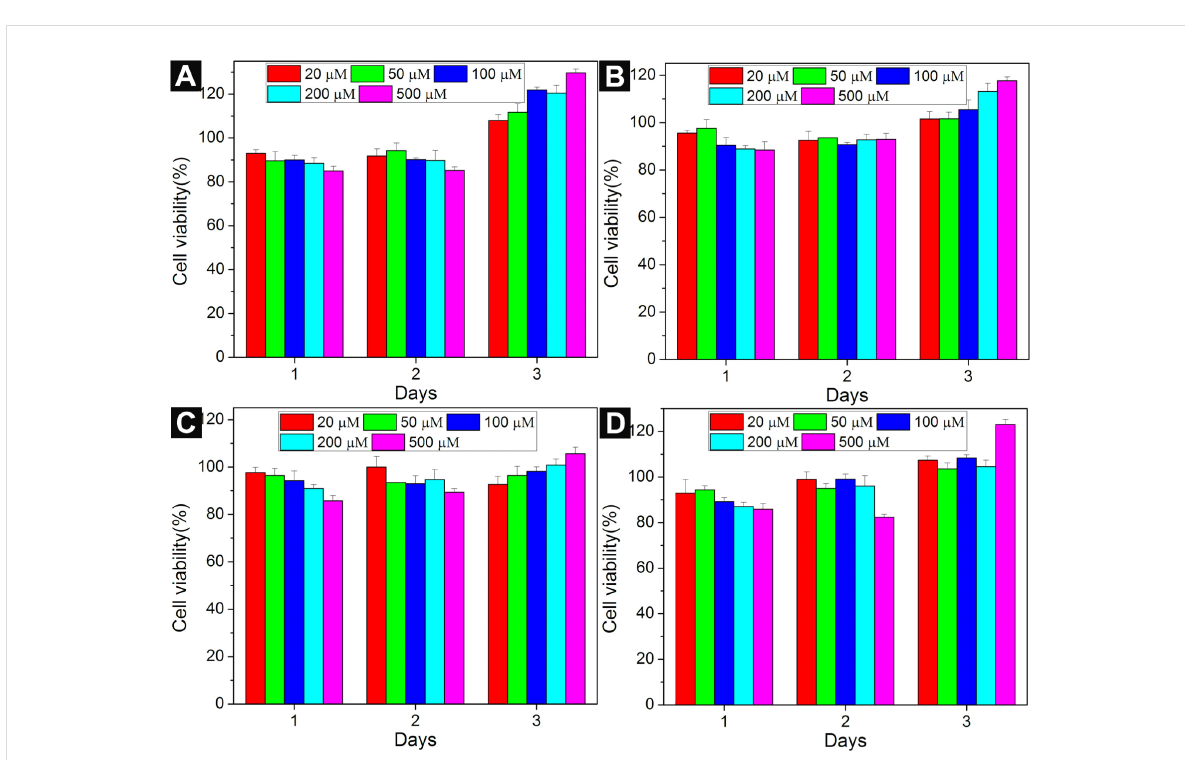
Figure 3: Cell viability of HeLa cells incubated with (A) 3 , (B) 4 , (C) 7 , (D) 8 at different concentrations for 3